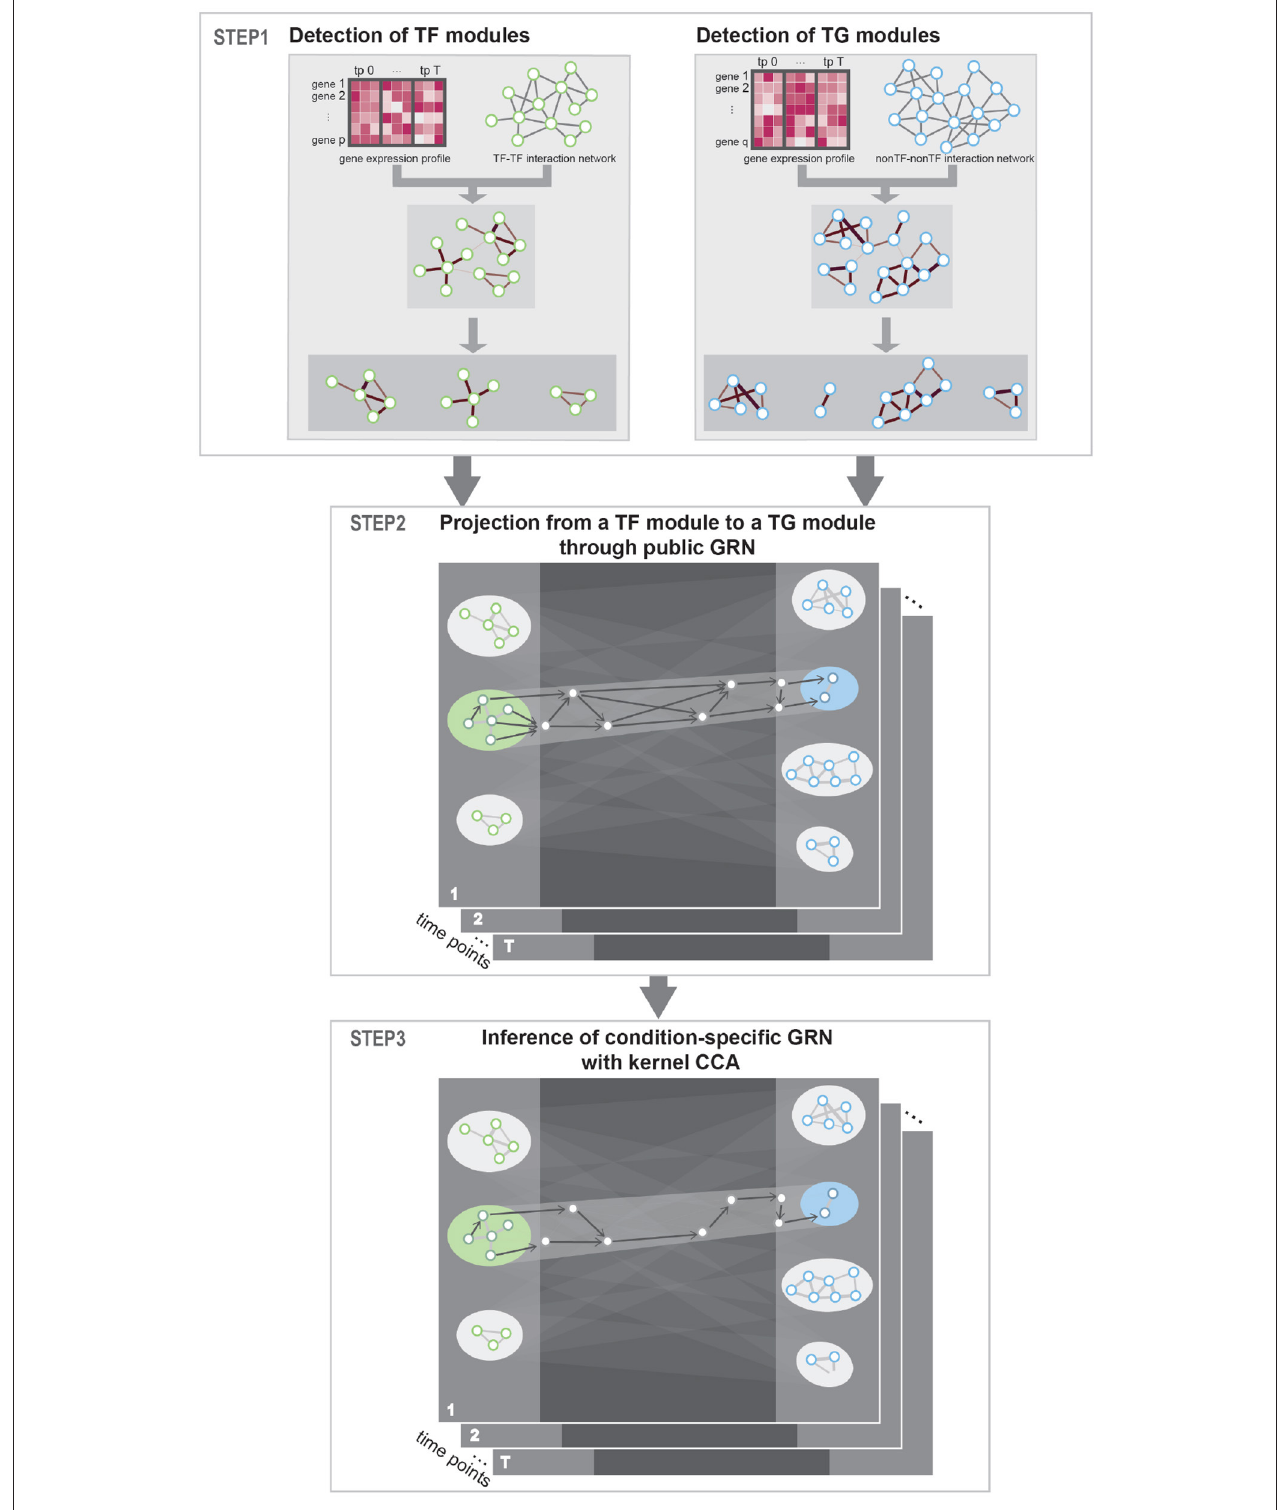
FIGURE 1 | Workflow. STEP 1: To detect interacting transcription factor (TF) and target gene (TG) modules, respectively, prior protein–protein interaction (PPI) network was instantiated with gene expression data and community detection algorithm was used to detect condition-specific TF and TG modules. STEP 2: To get putative TF–TG relations, we conducted projection from a TF module to a TG module through public gene regulatory network (GRN). This process is conducted for every possible TF–TG module pair. STEP 3: Utilizing kernel canonical correlation analysis (CCA), we constructed condition-specific GRN that detects multiple-to-multiple regulatory relationships between TFs and